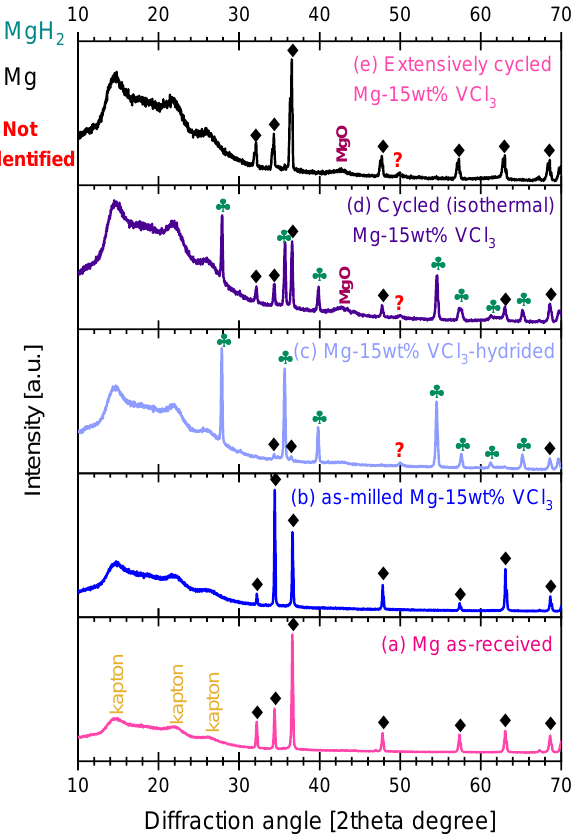
Figure 9. X-ray diffraction patterns of ( a ) as-received Mg, ( b ) cryogenically milled Mg-15wt.% VCl 3 , ( c ) material hydrided at 350 °C/26 bar of Figure 1, ( d ) material from the hydriding/dehydriding isothermal cycling of Figures 2 and 3; ( e ) from extensive PCI cycling.